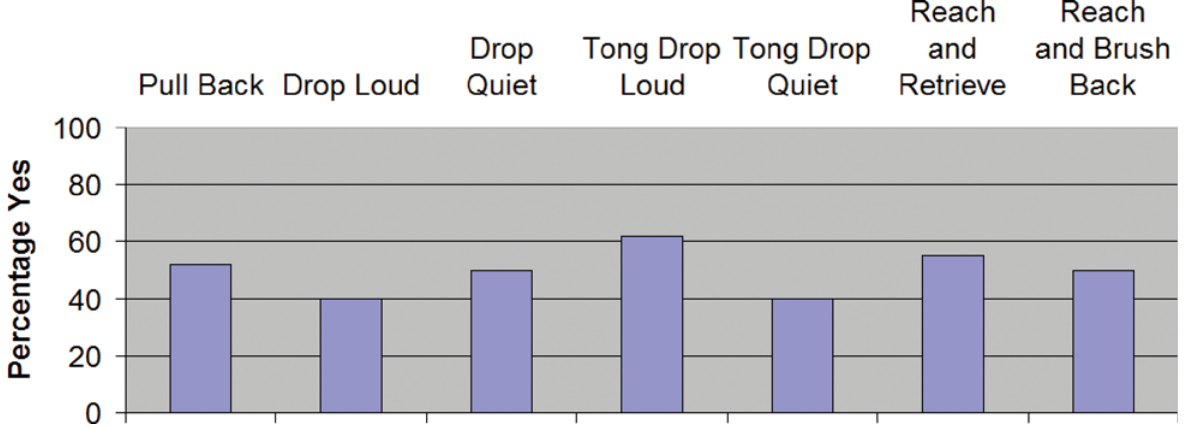
Fig 9. Binary yes/no ratings for Experiment 1 ("Did the afterimage of the action block disappear, fade or crumble immediately after taking the